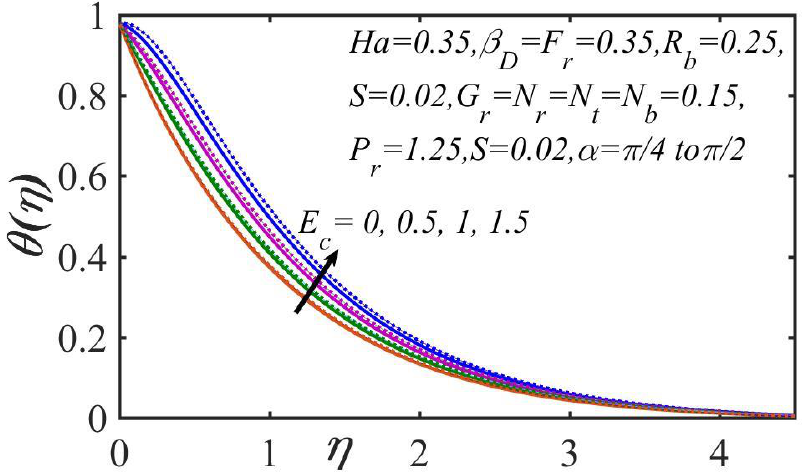
Figure 8. Influence of 𝐸 𝑐 and “ 𝛼 ” on temperature magnitudes. Solid curve: 𝛼 = 𝜋/4 ; dotted curve: 𝛼 = 𝜋/2.